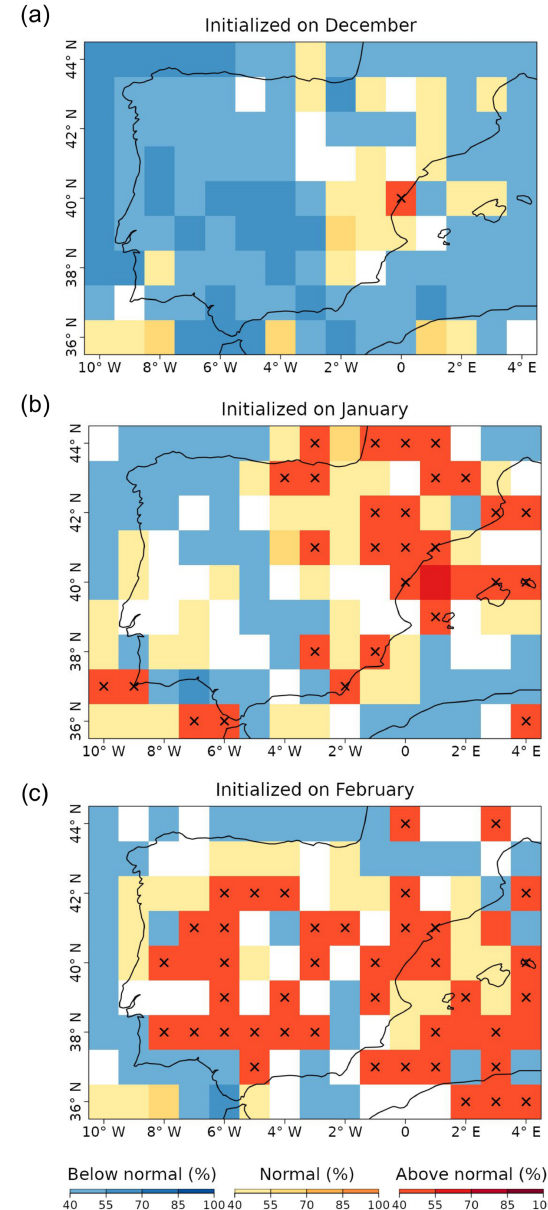
Figure 9. Probabilities of the most likely tercile for the March 2018 100m wind speeds, as indicated by the forecasts issued 3 to 1 month(s) ahead (top to bottom). The crosses indicate that the ob- servations fell into the most likely tercile displayed by the forecast. White grid points indicate that no tercile category has more than 40% of the